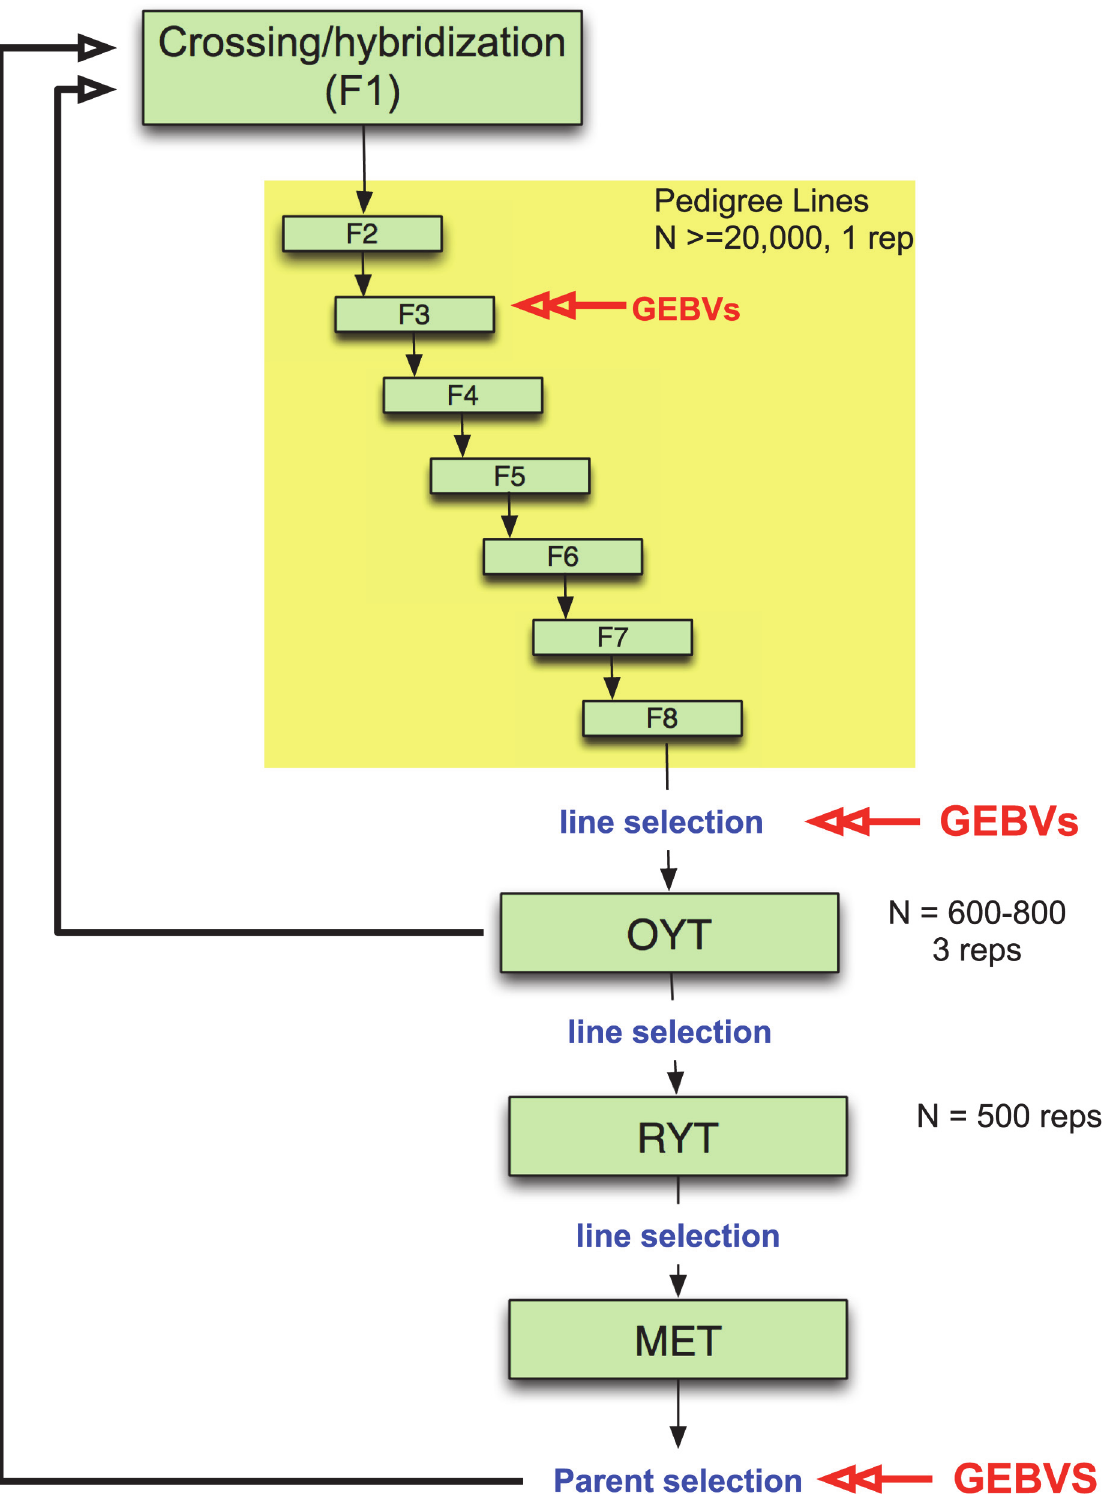
Fig 2. Example of irrigated rice breeding pipeline that incorporates genomic selection. Parents are selected and crossed to create an F1 population. * 20,000 F1 lines are fixed over 7 – 8 generations with selection of families for heritable traits with * 25% of the pedigree lines eventually selected for entry into the observational yield trial (OYT). GEBVs can be used at two or more generations during fixation as resources permit to perform selection. Here